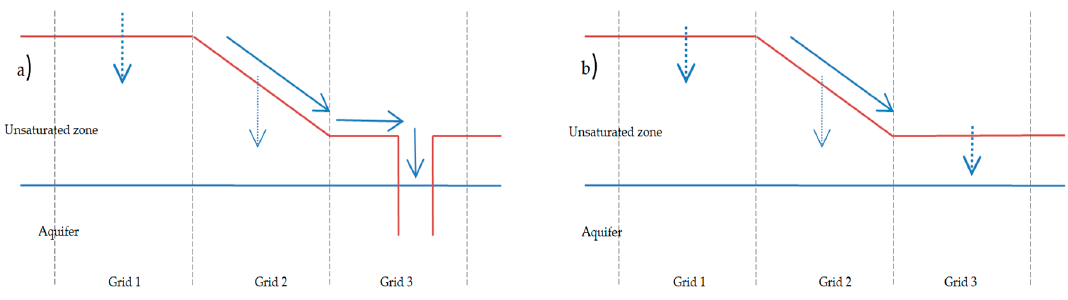
Figure 6. Influence of slope and soil texture in two scenarios: ( a ) Point infiltration; ( b ) di ff use infiltration. In ( a ), Grid 2 influences high vulnerability since it promotes a surface stream towards a swallow hole. In ( b ), the same grid would promote low vulnerability since vertical infiltration, at this grid, is minimized.